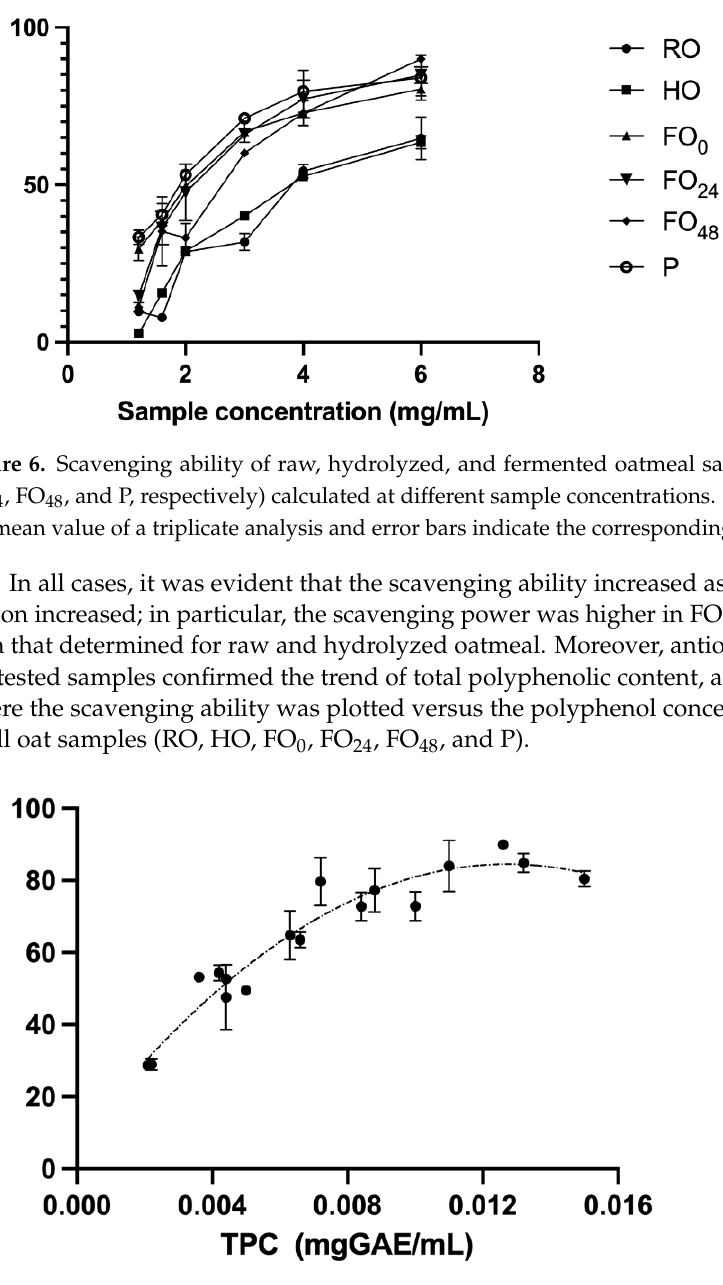
Figure 7. Scavenging ability versus total polyphenol concentrations (TPC) evaluated in oat samples. Each result represents the mean value of a triplicate analysis and error bars indicate the corresponding standard deviations.